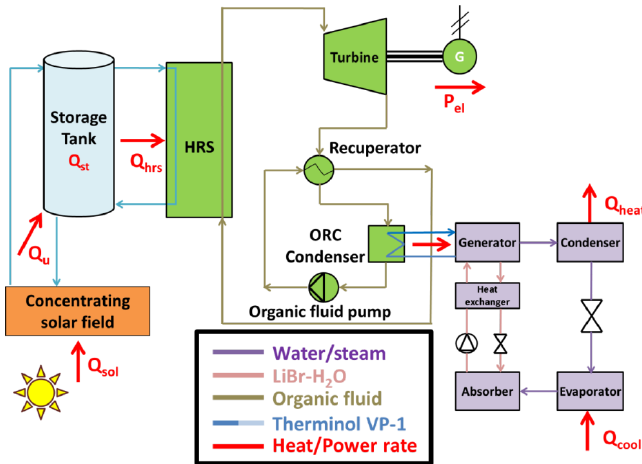
Figure 1. The investigated solar-driven trigeneration unit of this work. Table 1. Main data of the studied system.